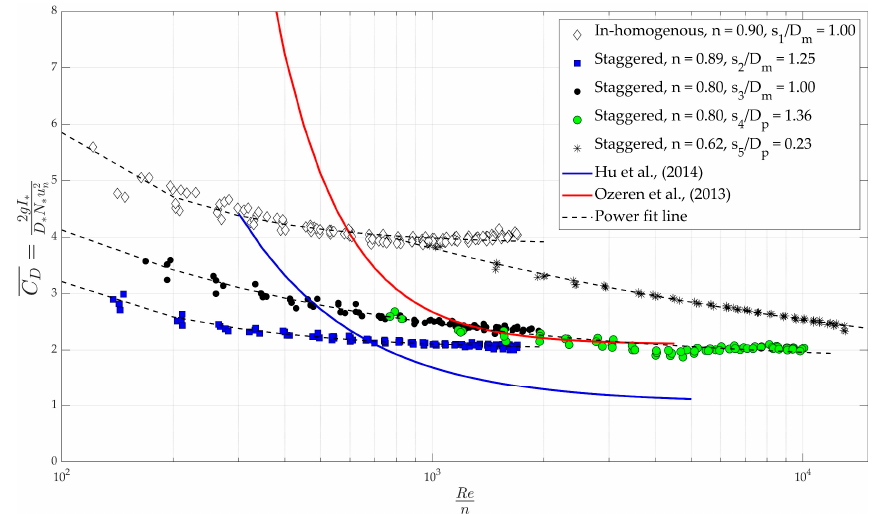
Figure 8. Relationship between Reynolds number ( Re n ) and the bulk of drag coe ffi cient ( C D ).